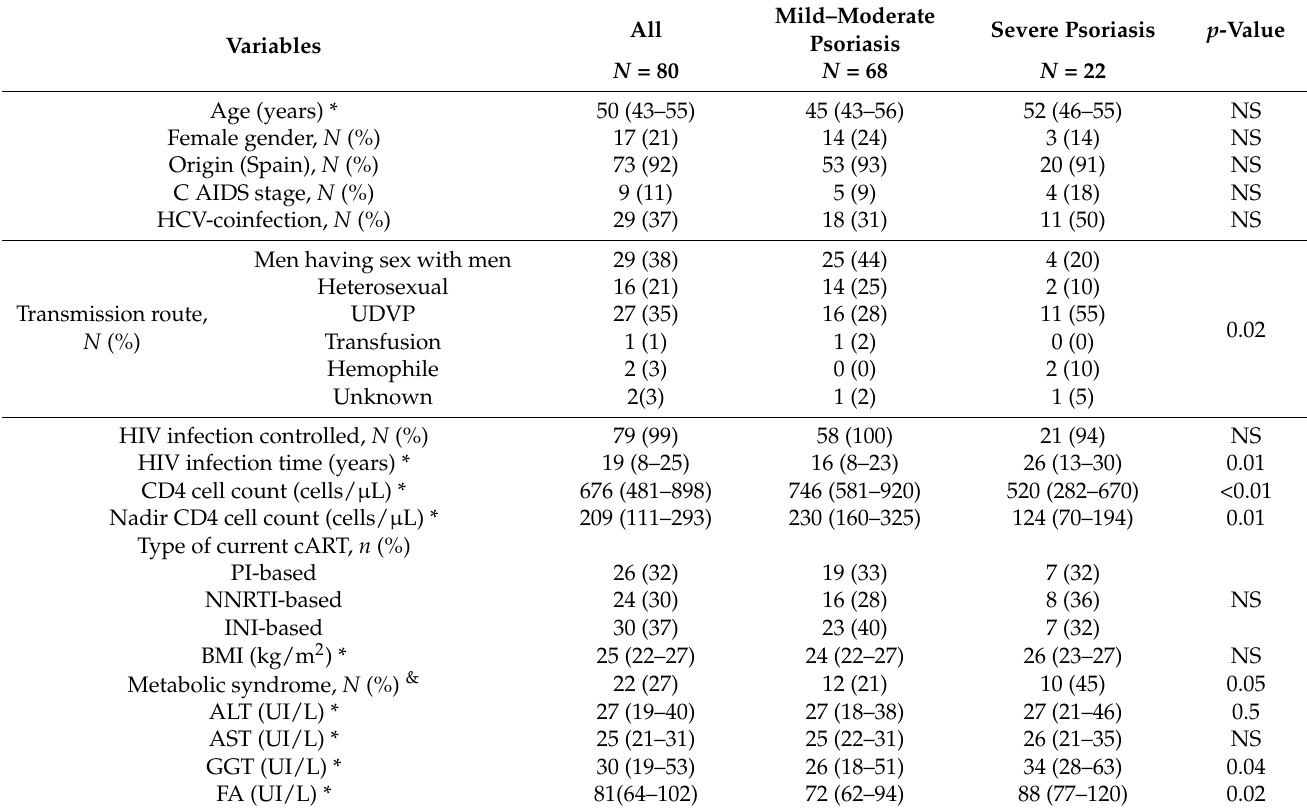
Table 1. Clinical